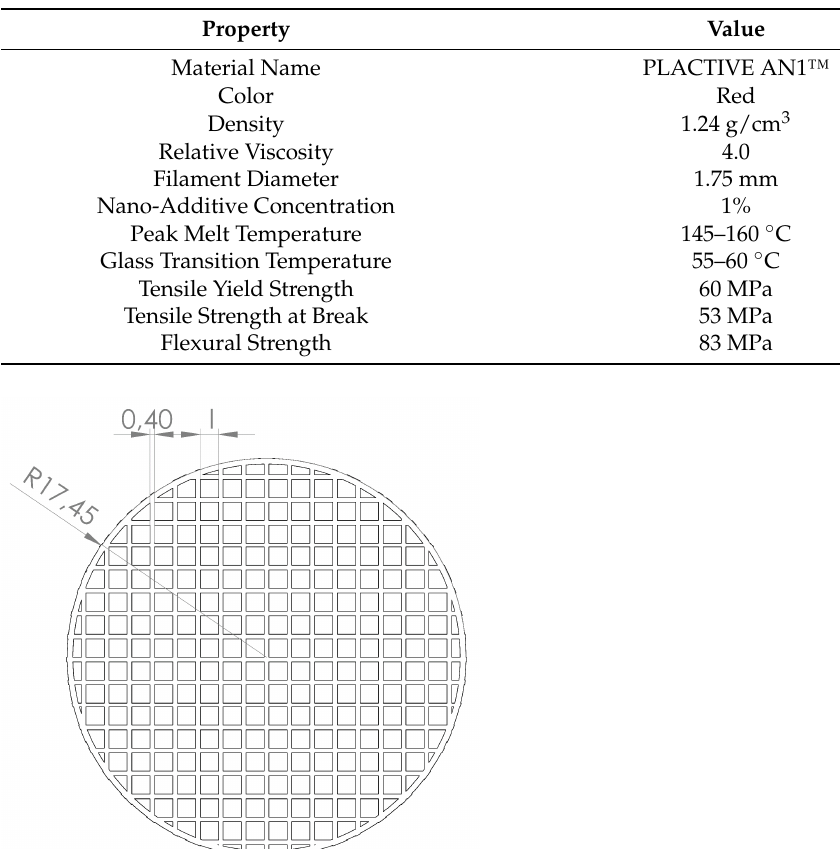
Table 1. Main PLACTIVE™ properties [1].